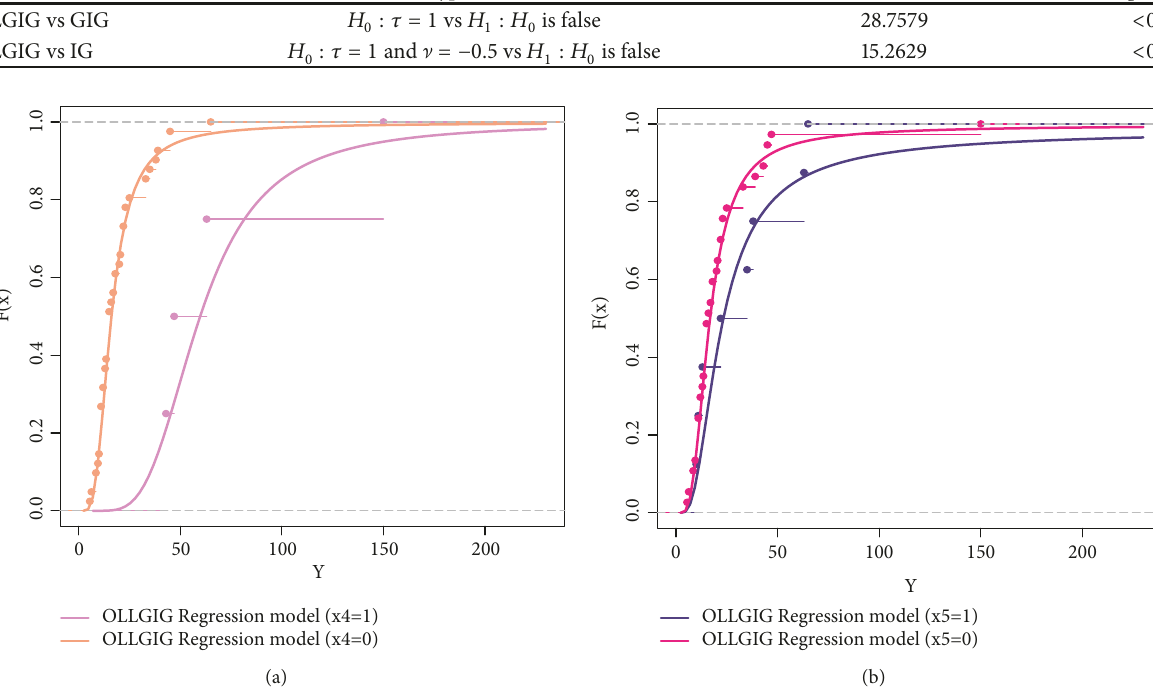
Figure 7: Estimated cdf from the fitted OLLGIG regression model and the empirical cdf for the price of urban property data. (a) Forcovariate 𝑥 𝑥 4 , and (b) for covariate 5 .